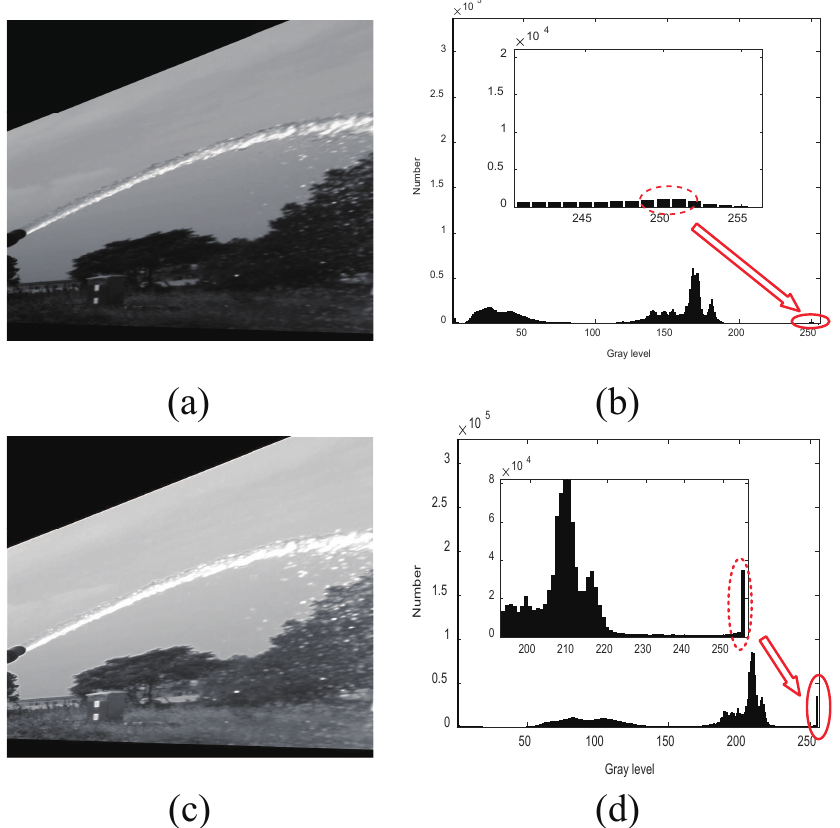
Figure 5. Results image with the proposed image enhancement method. ( a ) Original image; ( b ) gray histogram of ( a ); ( c ) enhanced image; and ( d ) Gray histogram of ( b